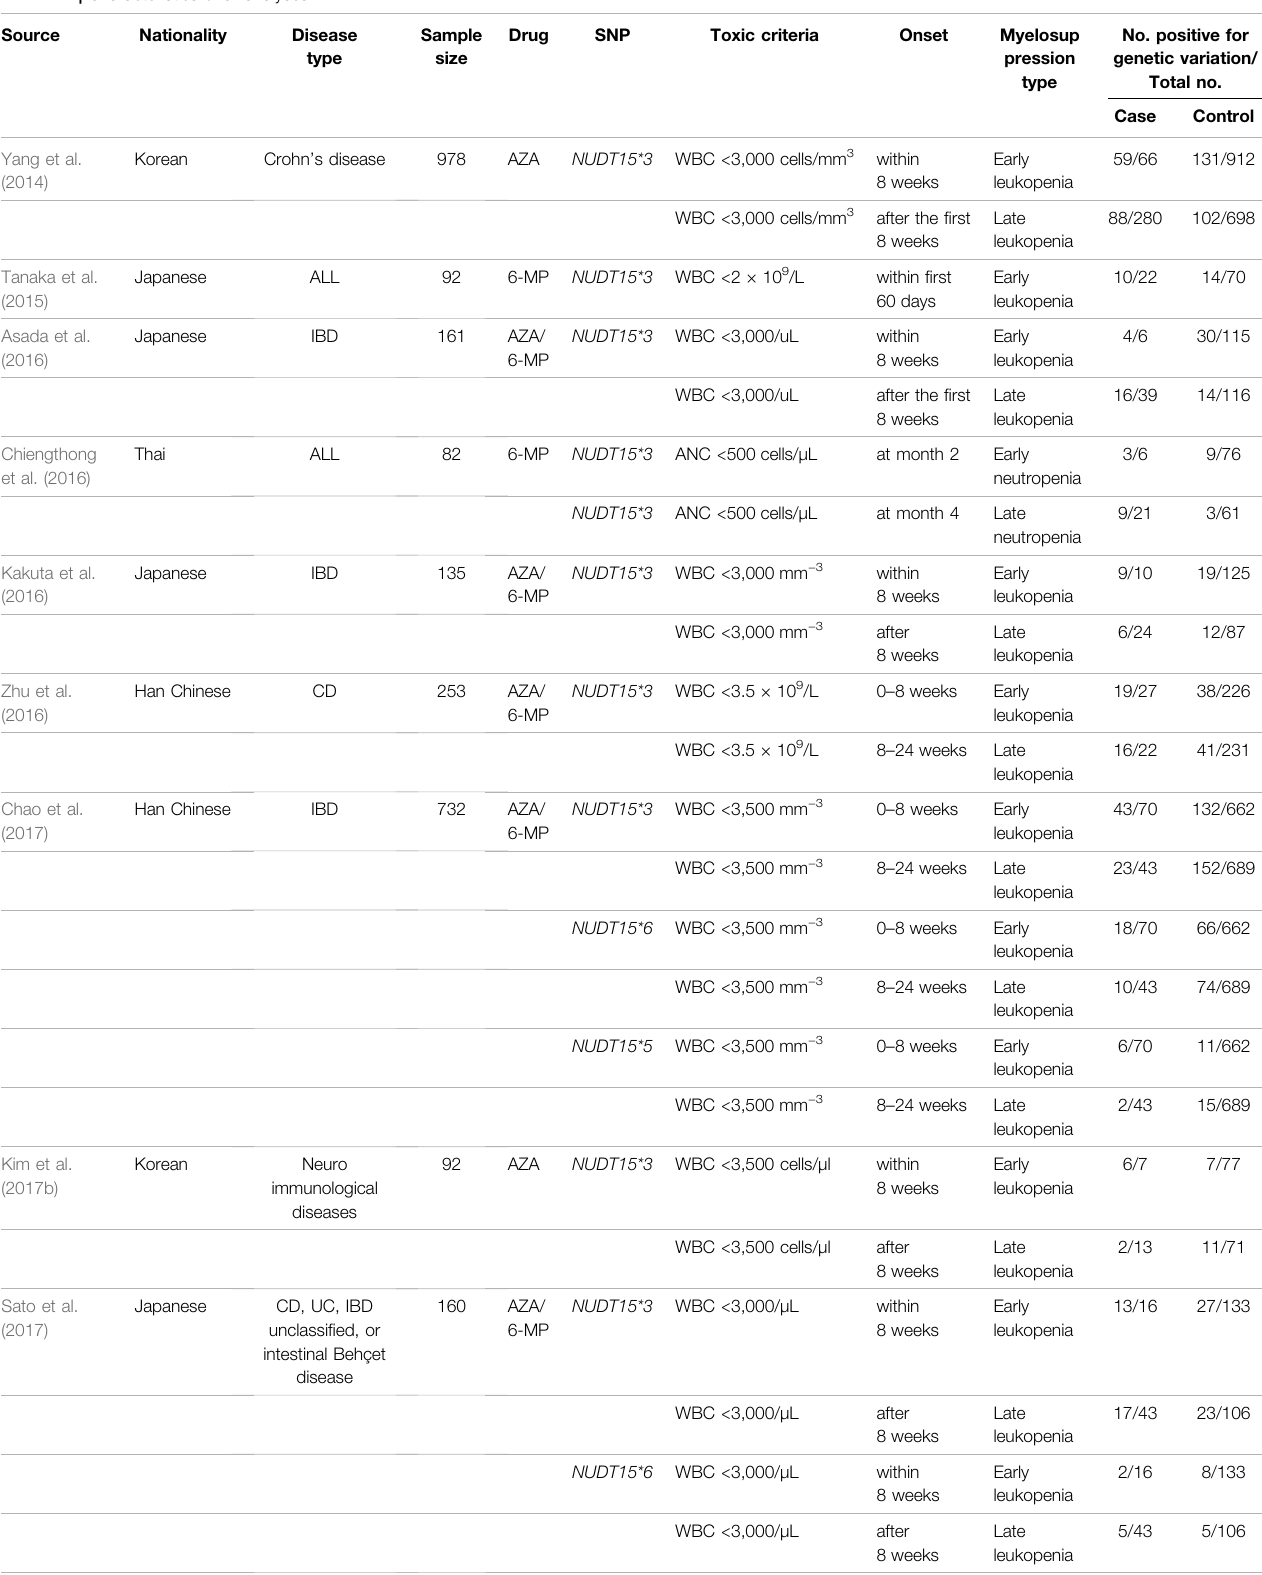
TABLE 1 | Characteristics of all